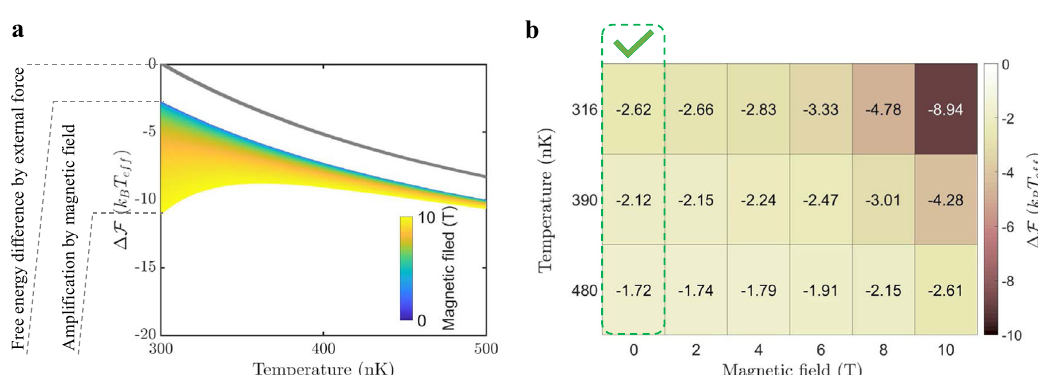
Fig. 2 Free energy ampli fi cation for a driven quantum system under a magnetic fi eld. a Free energy difference between two steady states of the closed quantum system in the experiment 34 : one state is undriven and the other is subject to a constant force. The force causes a free energy change, which can be ampli fi ed by adding a magnetic fi eld at low temperatures. The magnetic intensity is denoted by the color code. The horizontal axis is the effective temperature T eff implemented in the experiment and k B is the Boltzmann constant. b Free energy differences under a set of temperatures T eff and magnetic intensities B . The fi rst column for B = 0 T agrees with the measurement in Table 1 by An et al. 34 . The results with fi nite magnetic fi eld predict that the ampli fi cation becomes threefold ( ≈ 8.94/2.62) under B = 10 T and temperature 316 nK. The analytical formula in Eq. (3), and the parameter values can